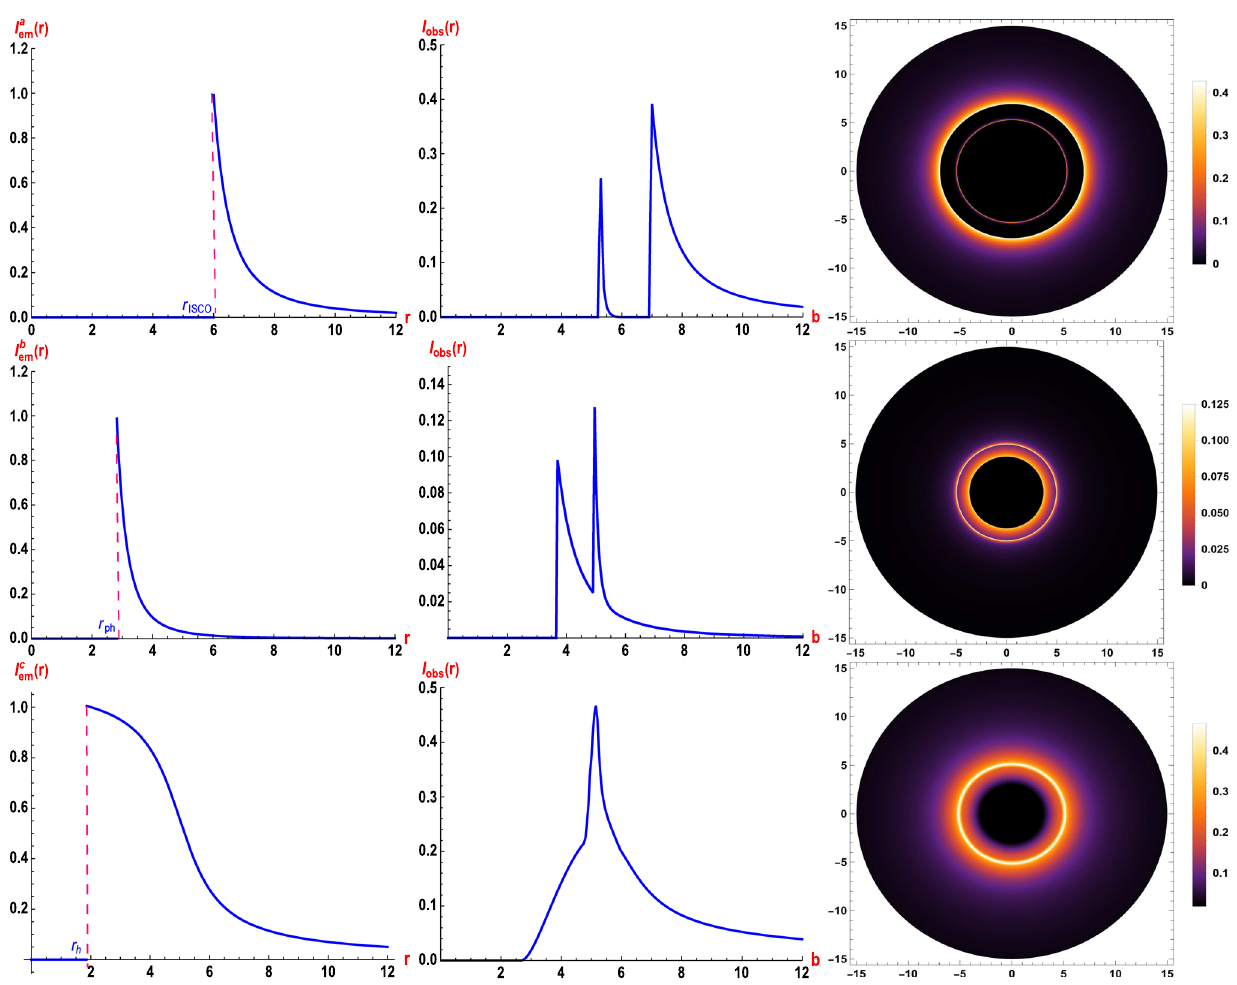
Fig. 7 The optical appearance of thin disk accretion with different emission flow profiles near the NC Charged Kiselev BH. The profiles are depicted for φ = 0 . 01 ,λ = 0 . 2 , Q = 0 . 1, and M = 1. The details can be found in the main